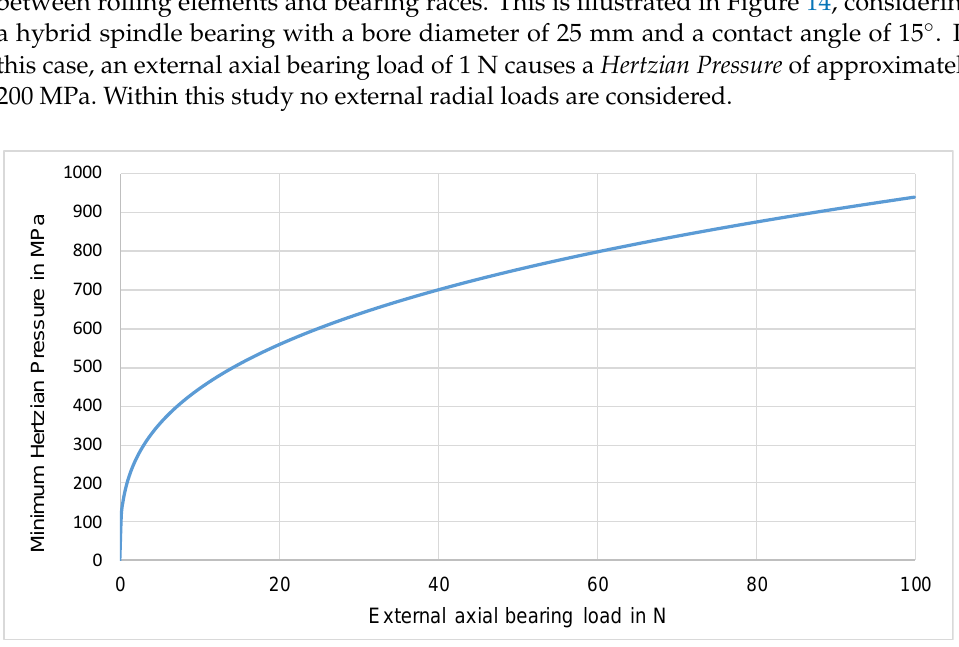
Figure 14. Minimum Hertzian Pressure in an angular contact spindle bearing with a bore diameter of 25 mm under solely axial load – Simulation conducted with MESYS Shaft (Version 07-2019, MESYS AG, Zürich).